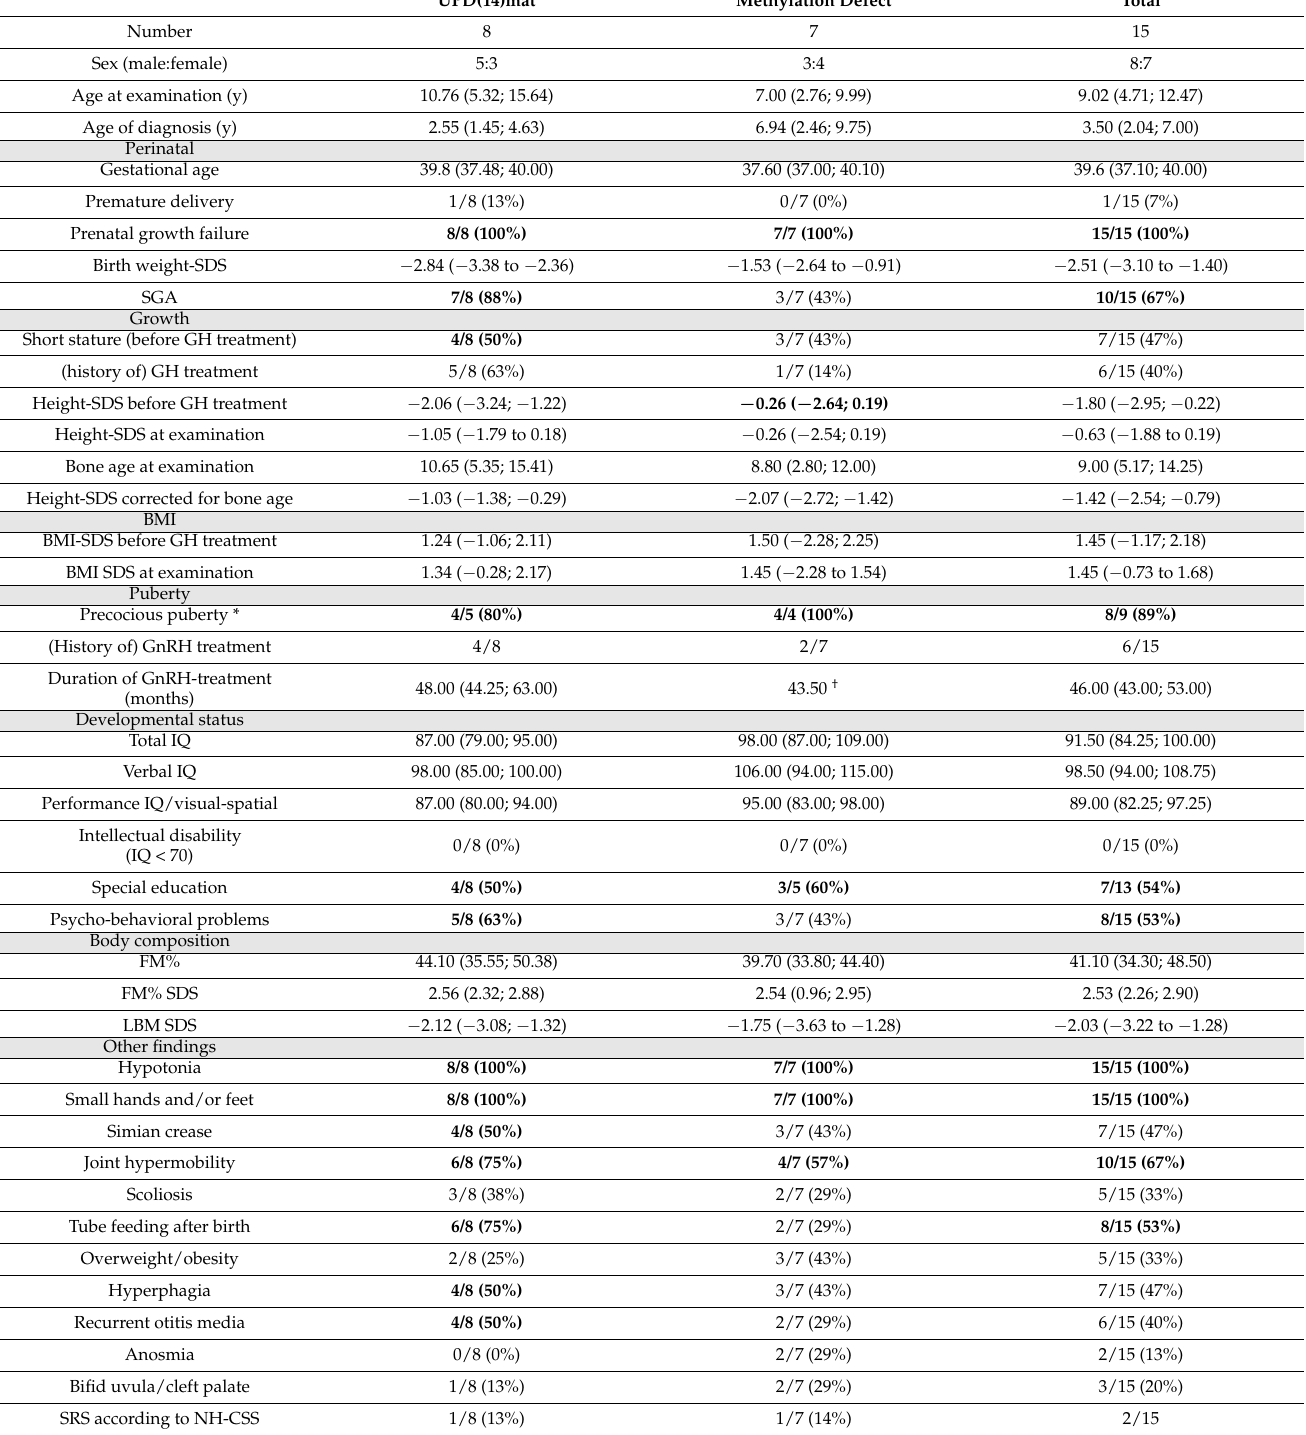
Table 1. Summary of clinical manifestations of patients with